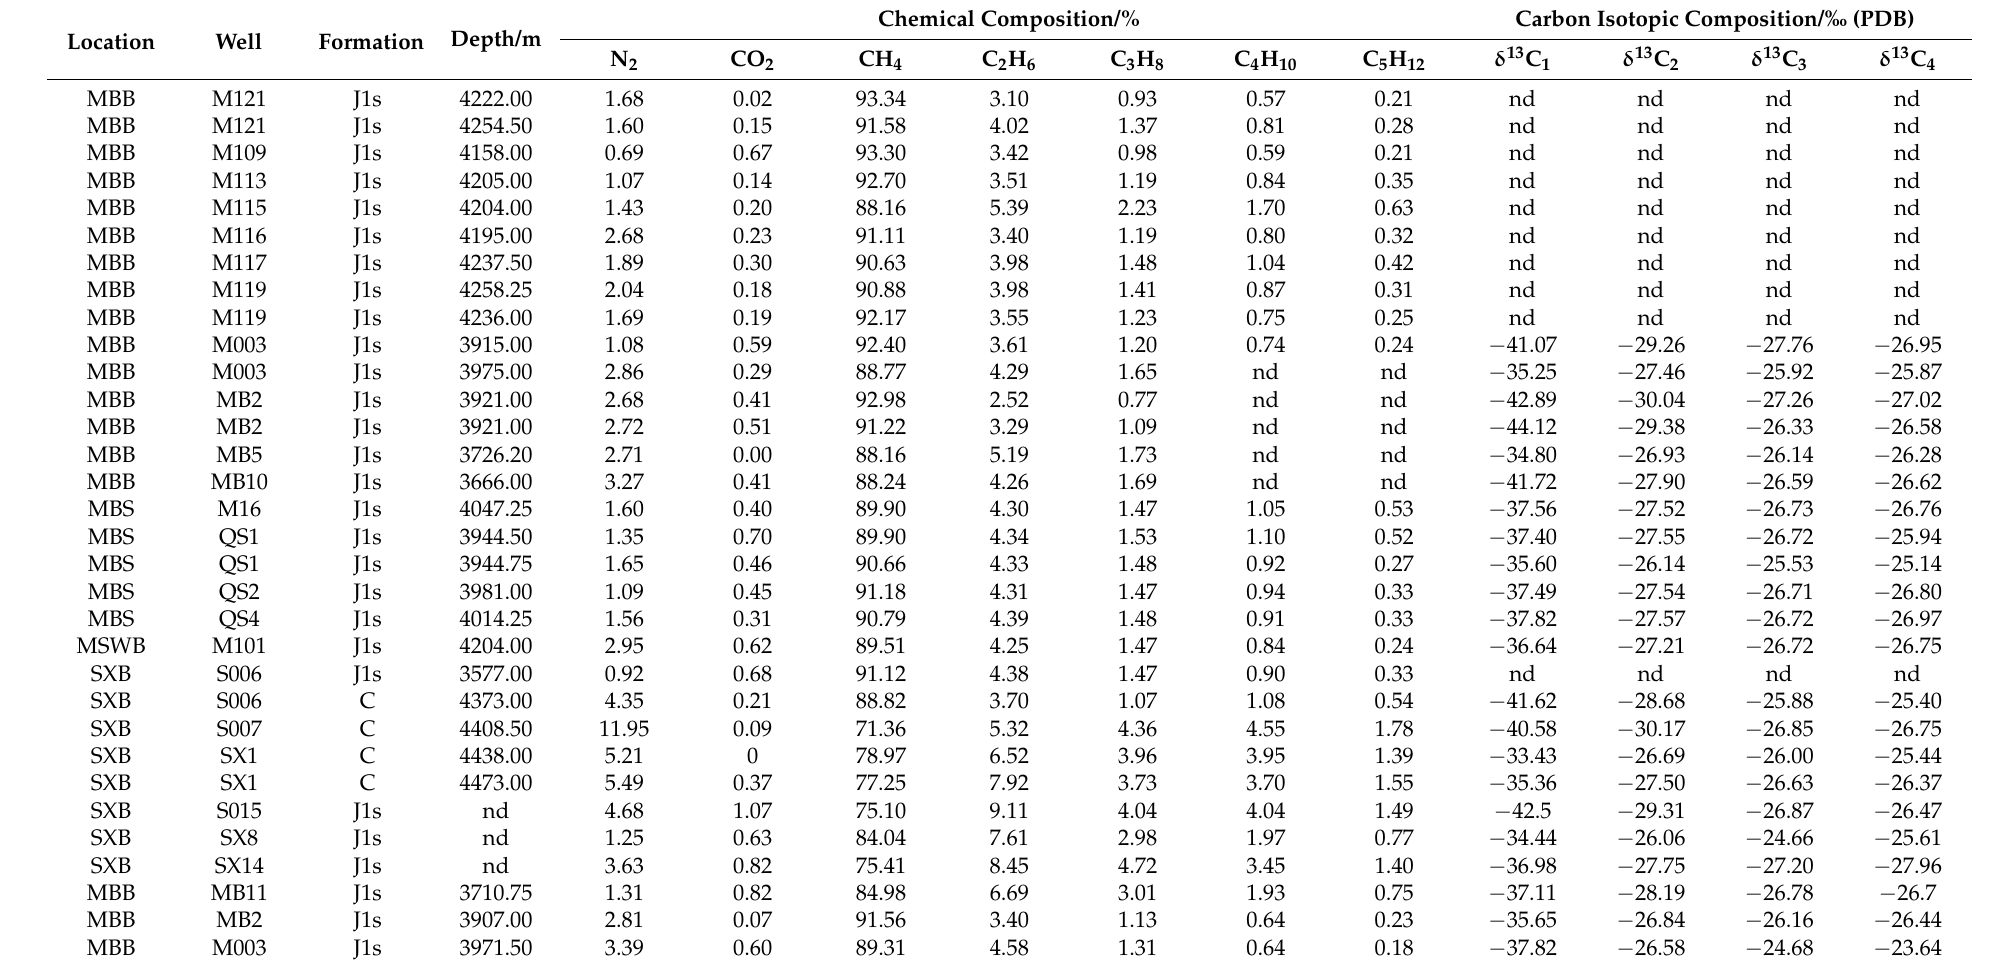
Table A1. Natural gas compositions in the eastern belt around the Penyijingxi Sag, Junggar